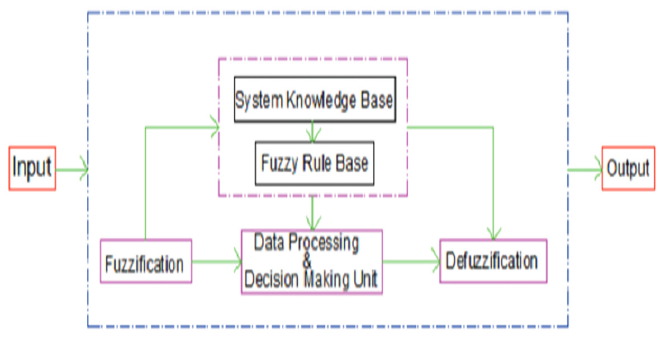
Figure 1. Components of the fuzzy inference system .